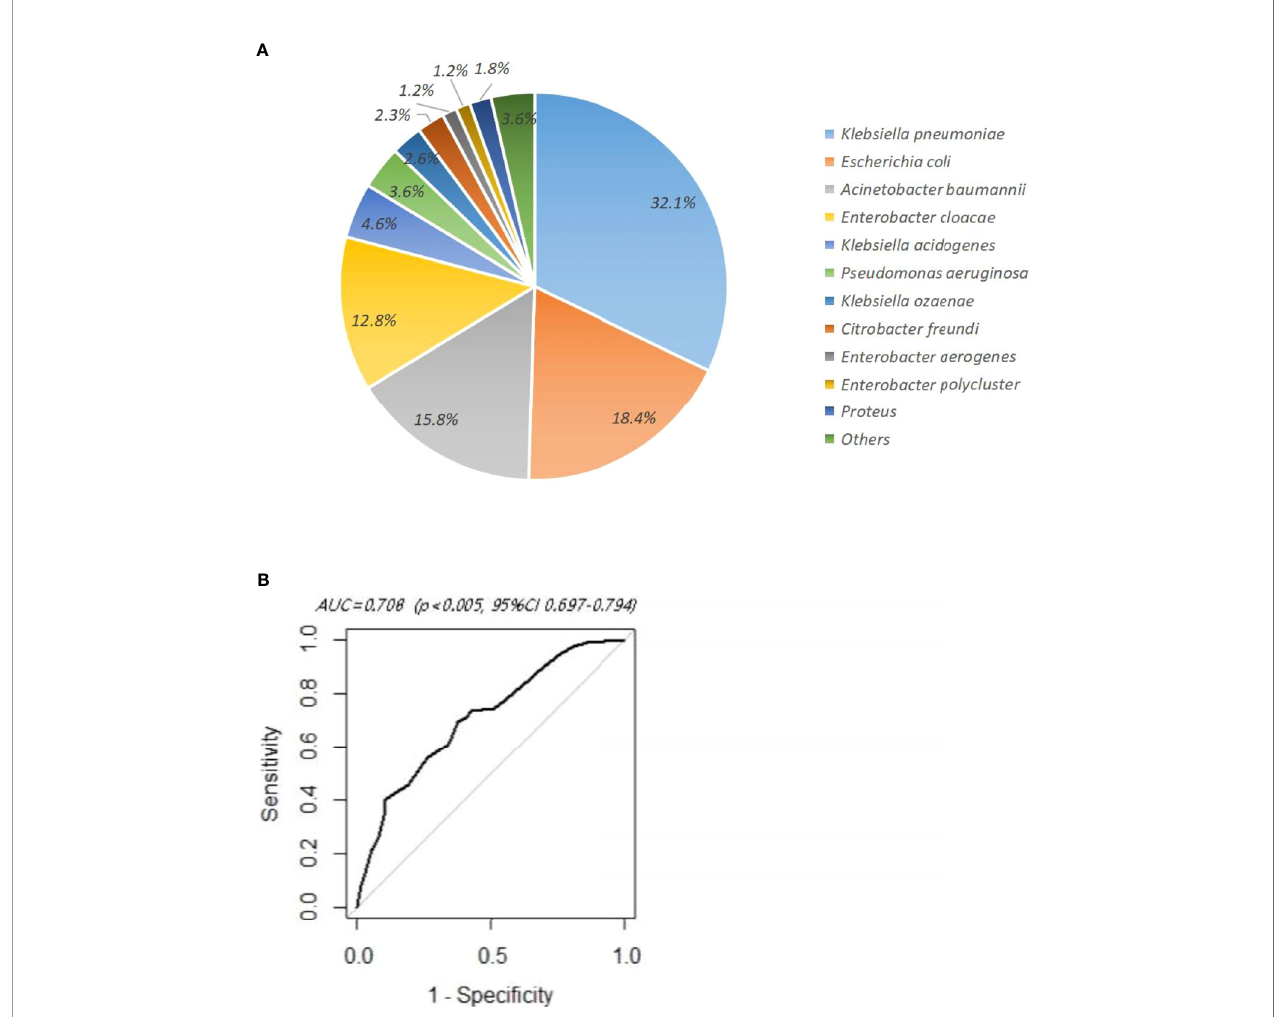
FIGURE 2 | (A) Distribution of carbapenem-resistant Gram-negative bacteria in rectoanal swabs. (B) ROC curve of multivariate logistic regression